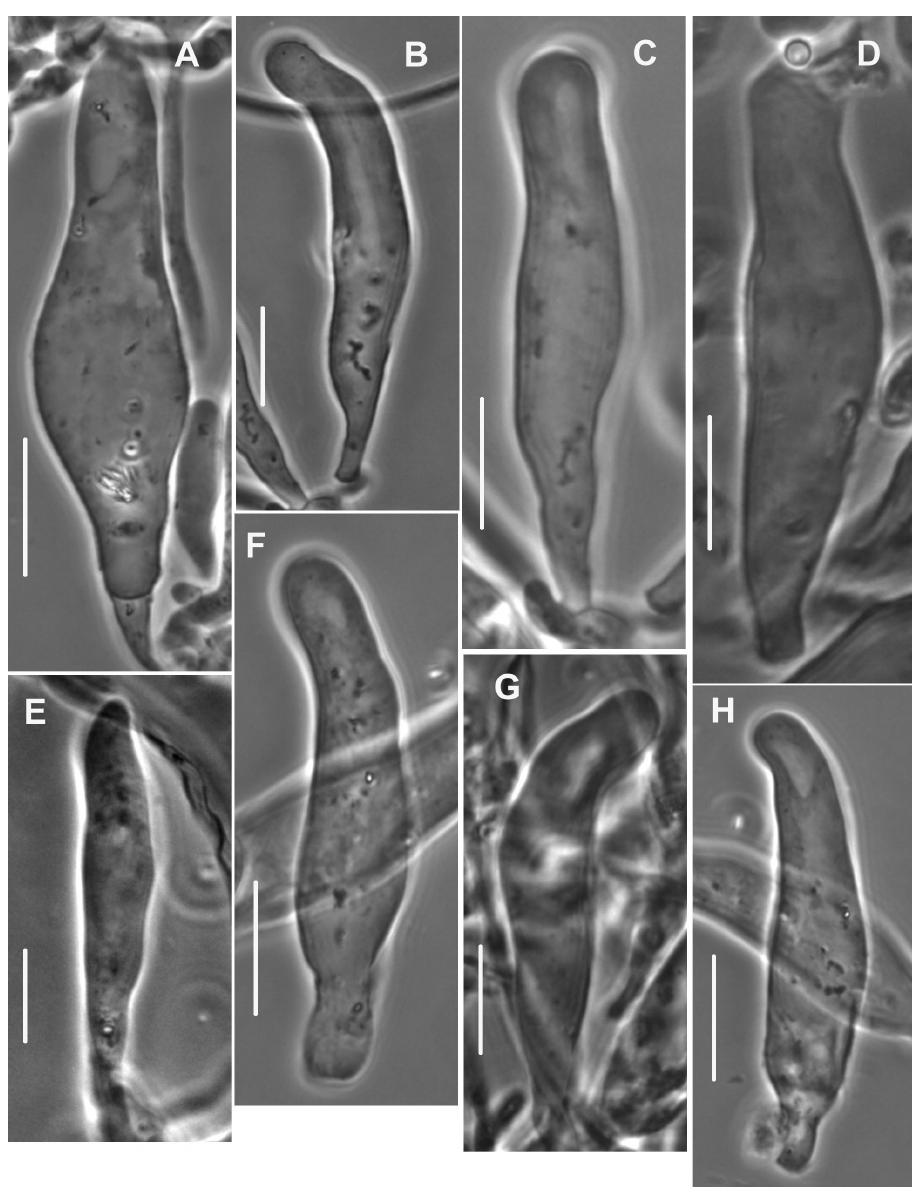
Figure 8. Mycetinis alliaceus . Cheilocystidia. Standard bars = 10 µm. TFB 11451. (TENN-F-59312).